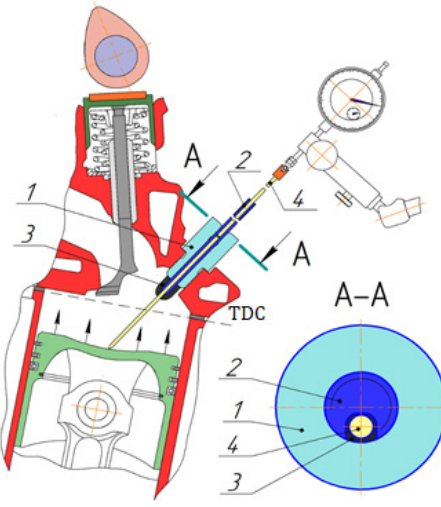
Figure 5. Diagram of the installation of elements when using a new method of diagnosing VT We prepare for the diagnostics in two stages (Fig. 6).